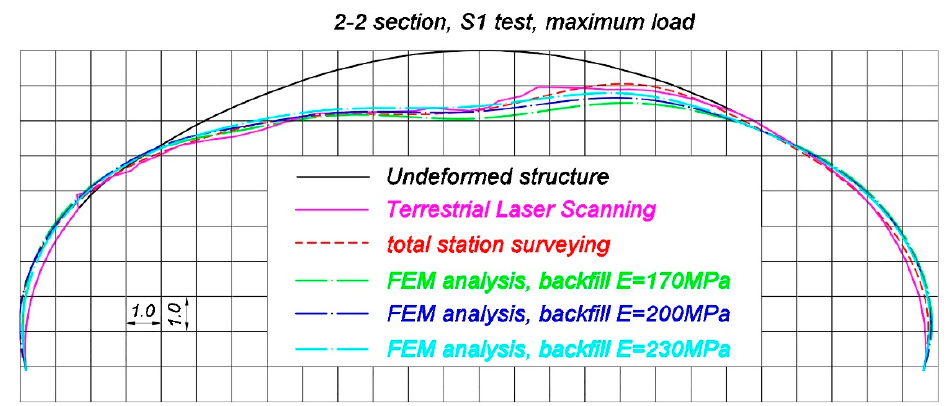
Figure 22. Comparison of the deformed shapes of the bridge in 2-2 section during the S1 test, when maximum load was applied, measured using terrestrial laser scanning, total station, and estimated by means of FEM (deformations in (mm) are 1000 times scaled).